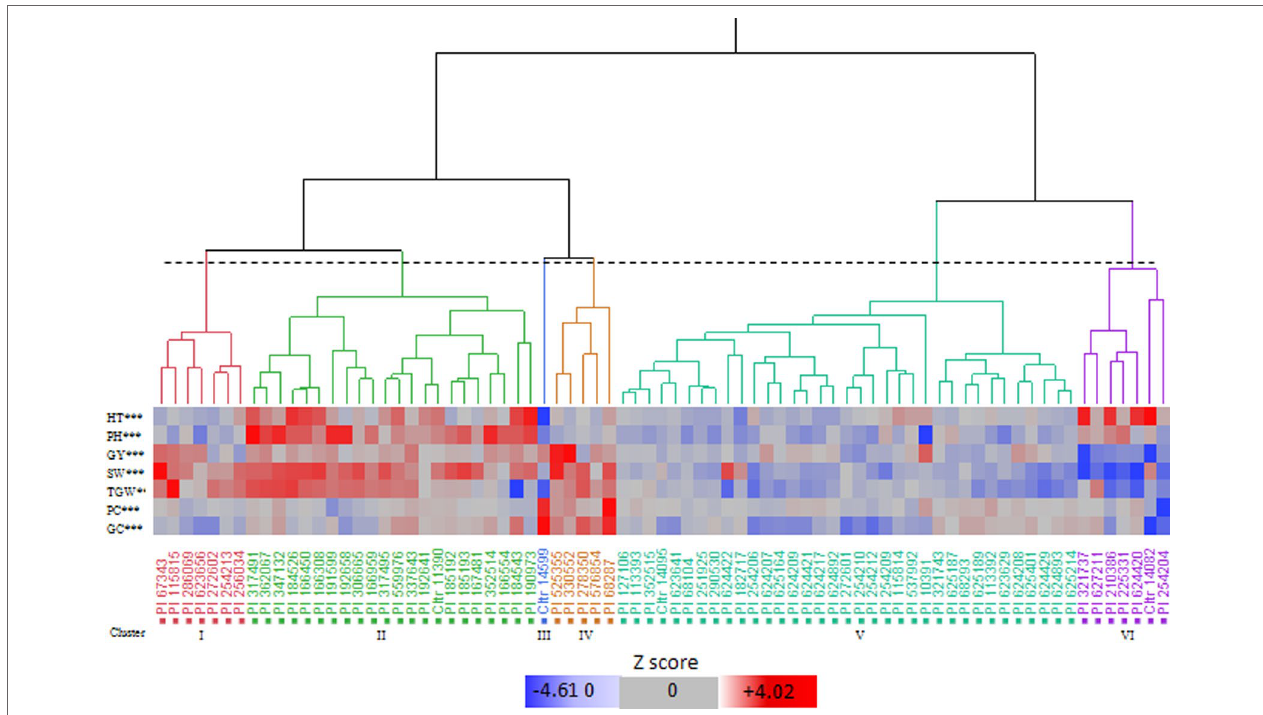
FiGUre 1 | Hierarchical cluster analysis dendrogram (Ward’s method) and pattern map of the values of the bio-agronomic traits for the 77 Khorasan wheat genotypes. HT, heading time; PH, plant height; GY, grain yield; SW, specific weight; TGW, 1000-grain weight; PC, protein content; GC, gluten content. Dotted line, 20% threshold point delineating six clusters. ***, significant differences at 0.001 level among clusters (Tukey-Kramer test).